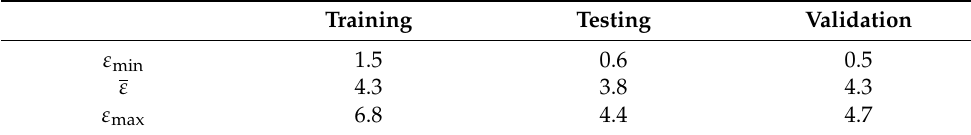
Table 8. Performance statistics for the non-dominated set.